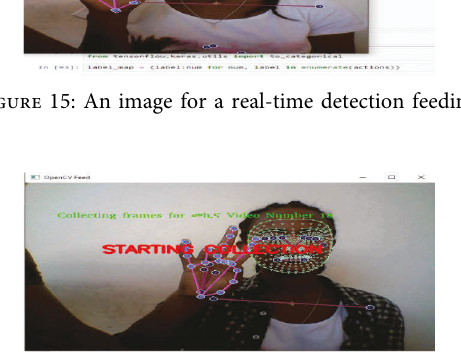
Figure 16: Image of real-time detection for Amharic word “ ”